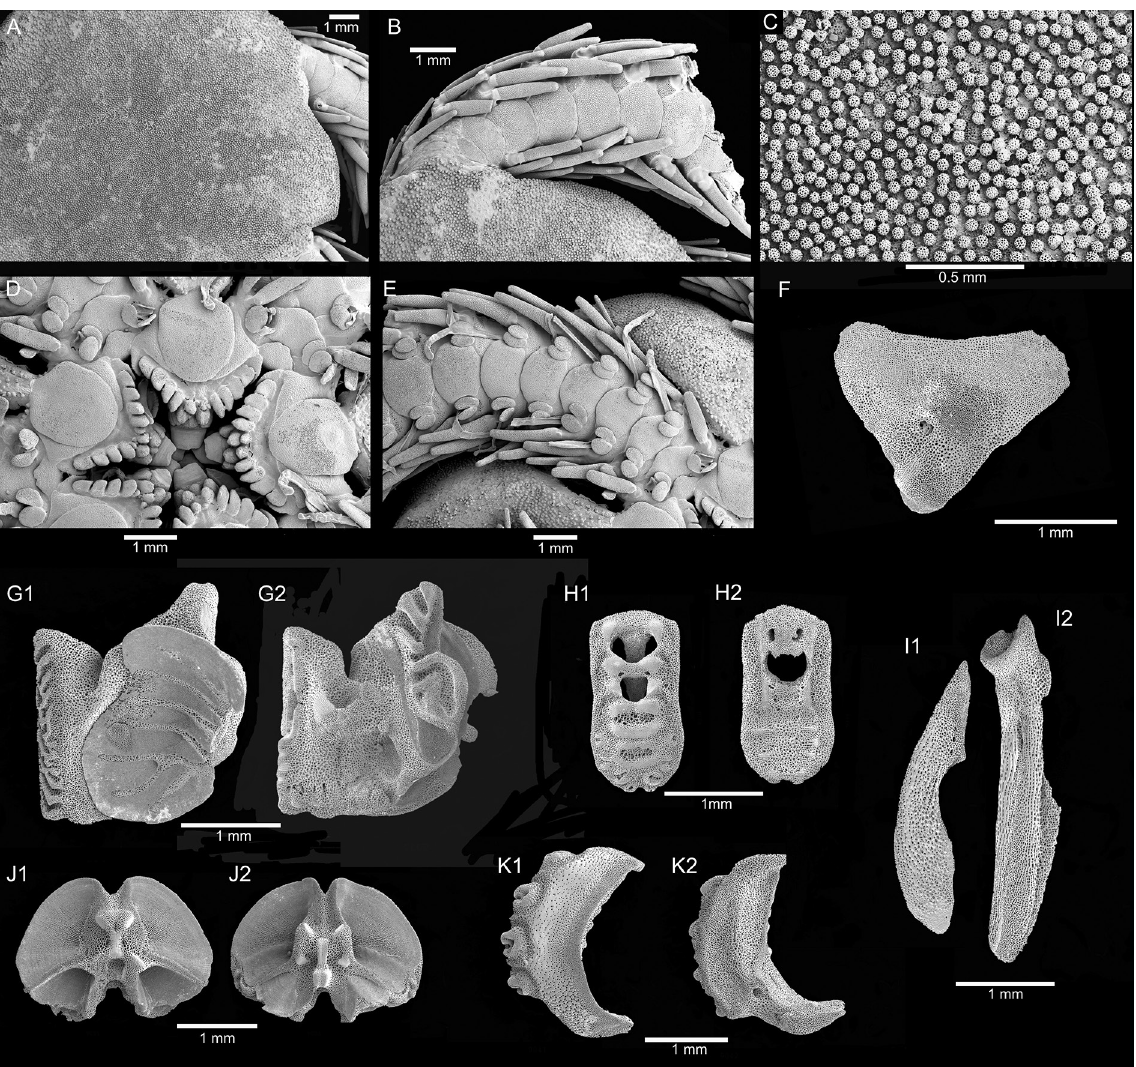
Fig. 3. Ophiocoma ( Breviturma subgen. nov.) doederleini de Loriol, 1899 (UF5318). SEM images. A . Dorsal disc. B . Dorsal arm. C . Dorsal disc granules. D . Jaws. E . Ventral arm. F . Radial shield, internal aspect, distal edge downwards. G . Oral plates (half-jaws), abradial aspect left, adradial right, proximal edge left. H . Dental plates, external aspect on left, internal on right (lower septum broken), dorsal upwards. I . Genital plates abradial left, adradial right, distal upwards. J . Arm vertebrae, proximal aspect left, distal right, dorsal upwards. K . Lateral arm plates, external aspect left, internal right, distal to the right. UF, Florida Museum of Natural